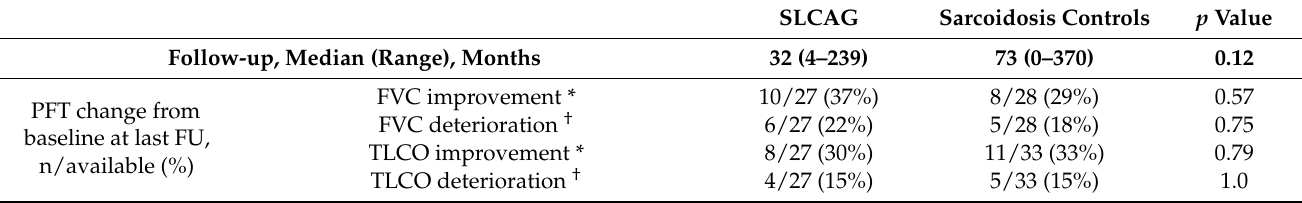
Table 4. Treatment and outcome of SLCAG patients and sarcoidosis controls. SLCAG Sarcoidosis Controls p